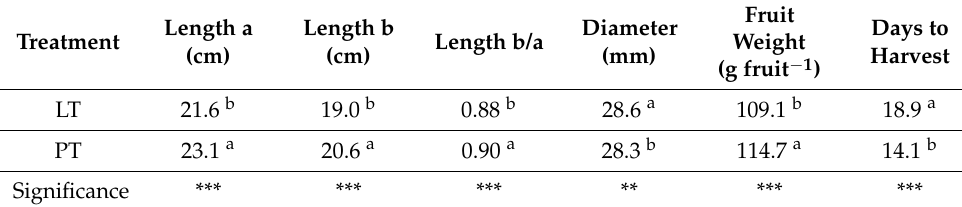
Table 7. Effect of training methods on fruit shape, size, and dwell